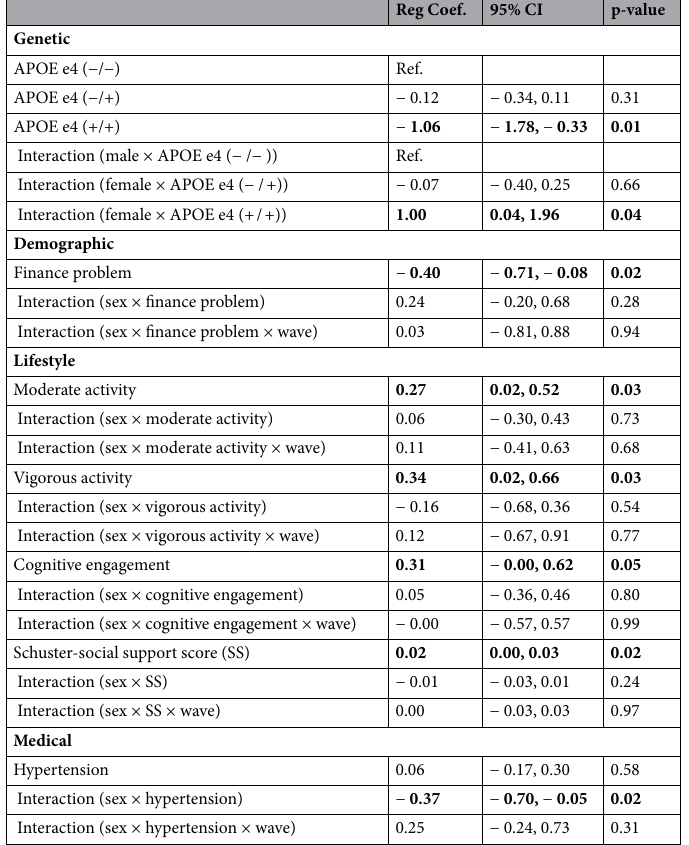
Table 3. Dementia risk factors effects on memory performance, and dementia risk factor interactions with sex, and sex and wave (60 s cohort). Bold values indicate p<0.05. Adjusted for age, race, non-English speaking background, year of education and data collection wave.